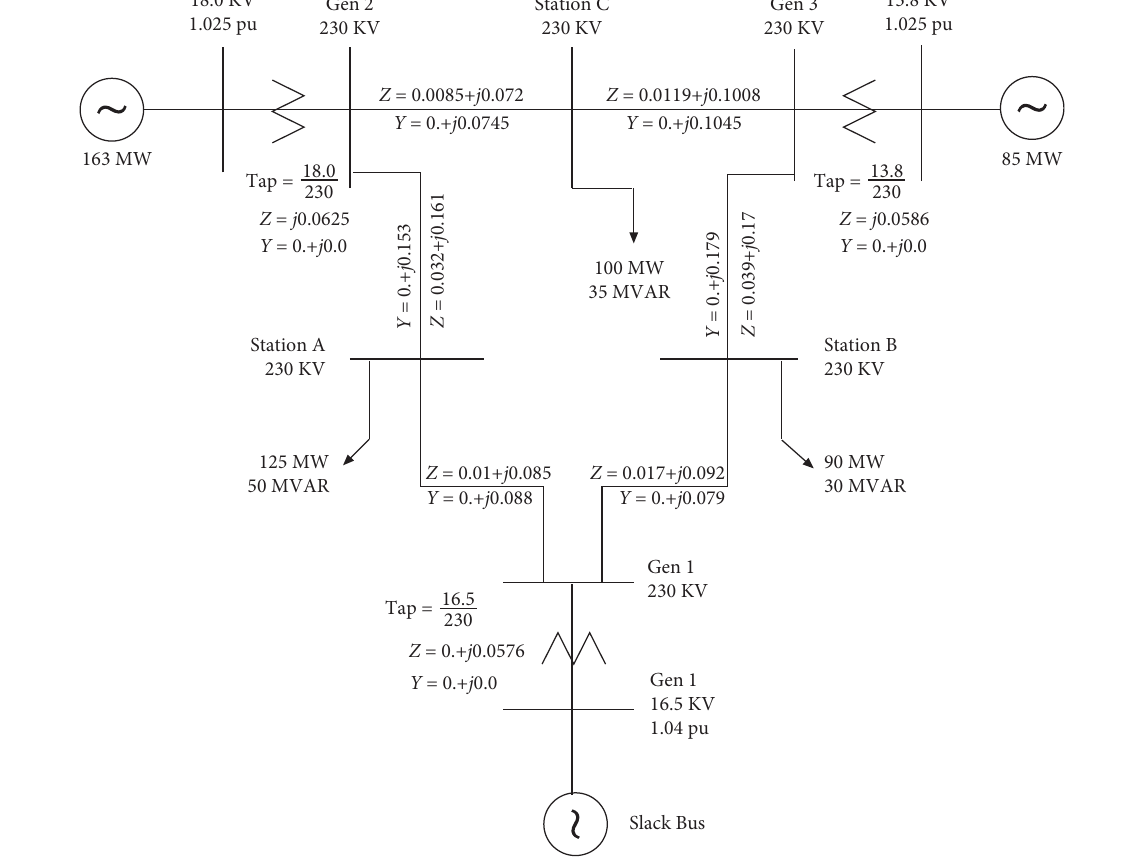
Figure 1: WSCC 3-machine, 9-bus system [2]. Table 1: Machine